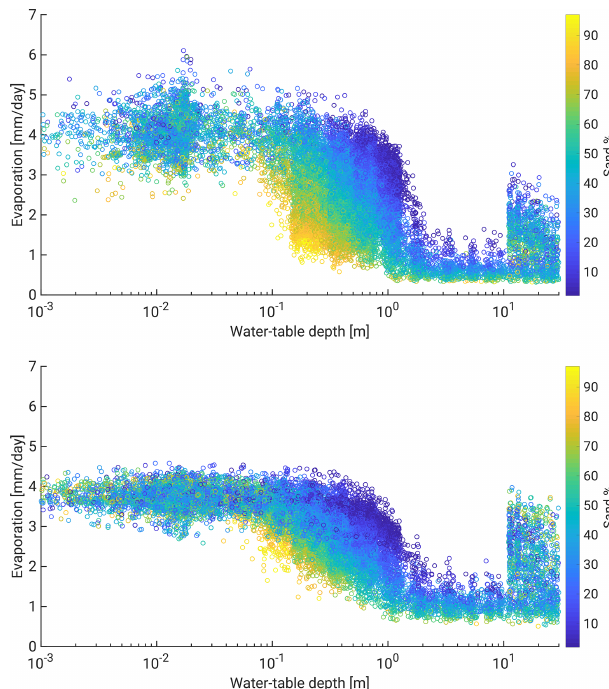
Figure 3. Daily average evaporation simulated for 30 April (too) and 31 July 2007 (bottom) in mmd − 1 . The color indicates soil sand